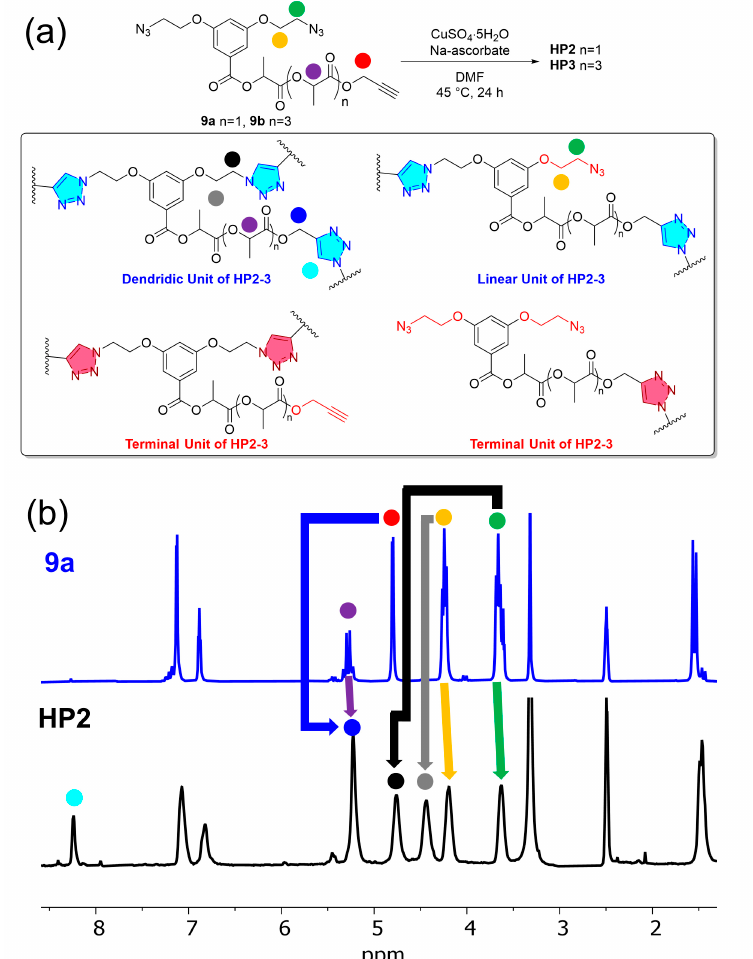
Figure 3. ( a ) Polymerization scheme of monomers 9a–b , and ( b ) stacked 1 H NMR spectra in DMSO- d 6 of monomer 9a (blue line) and hyperbranched polymer HP2 (black line).